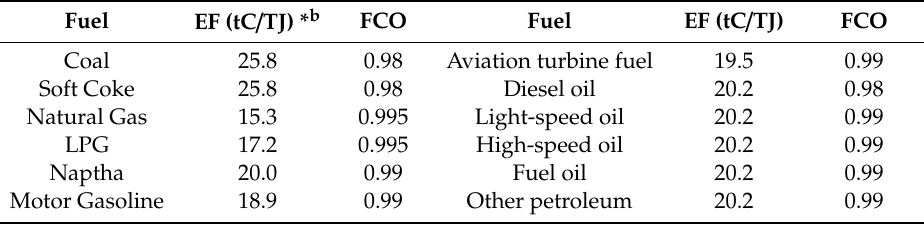
Table 1. Carbon emission factor (EF) and fraction of carbon oxidized (FCO) * a . Fuel EF (tC / TJ) * b FCO Fuel EF (tC / TJ)